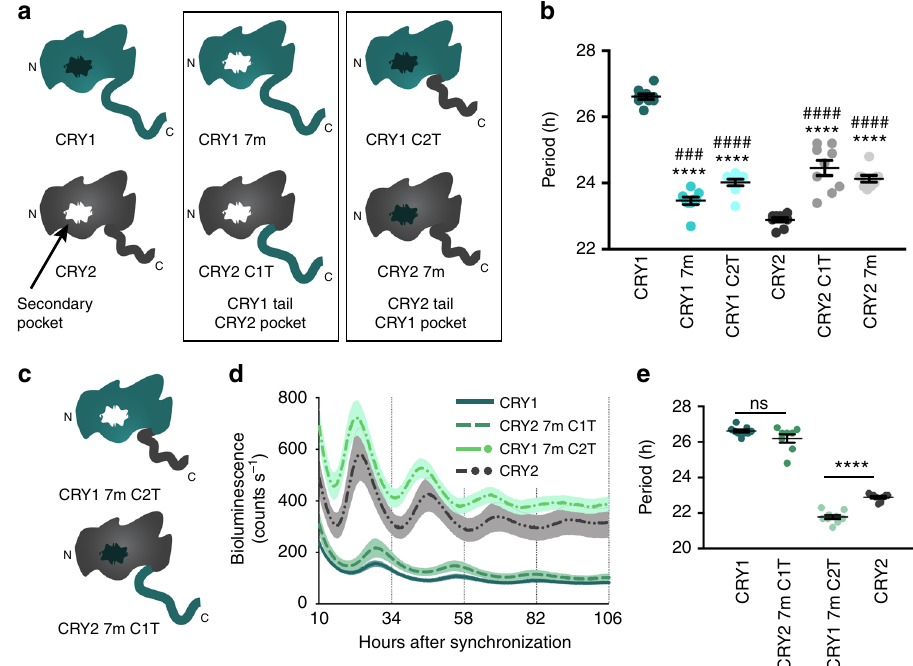
Fig. 8 Both the CRY1 pocket and tail are required to recapitulate the long period length of Cry1 rescues. a Models of chimeric CRYs used in the experiments in this fi gure. CRY1-like and CRY2-like pockets are shown in black and white, respectively. The fi rst column shows WT CRY1 and CRY2; the second column shows CRYs with CRY1 tails and CRY2-like pockets; the fi nal column shows CRYs with CRY2 tails and CRY1-like pockets. b Shows a period plot from experiments in which either the tail or pocket of CRY1 and CRY2 was exchanged for its paralog. Data are shown here as mean ± SEM ( n = 9 plates per condition from three independent experiments. Asterisks show signi fi cance by unpaired t test with Welch ’ s correction compared to WT CRY1 (**** p < 0.0001). Hashes denote signi fi cance by unpaired t test with Welch ’ s correction compared to WT CRY2 ( ### p = 0.0006, #### p < 0.0001). c Models depicting CRY chimeras in which both the pocket and tail have been exchanged for paralogous residues. d Rescue assays performed with WT CRY1, CRY2 7m C1T (CRY2 7m with CRY1 tail (res 498 – 606)), CRY1 7m C2T (CRY1 7m with CRY2 tail (res 516 – 593)), and WT CRY2 shown as mean ± SEM ( n = 9 plates per condition from three independent experiments). e Period plot of the data shown in d . Mean ± SEM indicated by bars. Asterisks show signi fi cance by unpaired t test with Welch ’ s correction (**** p <